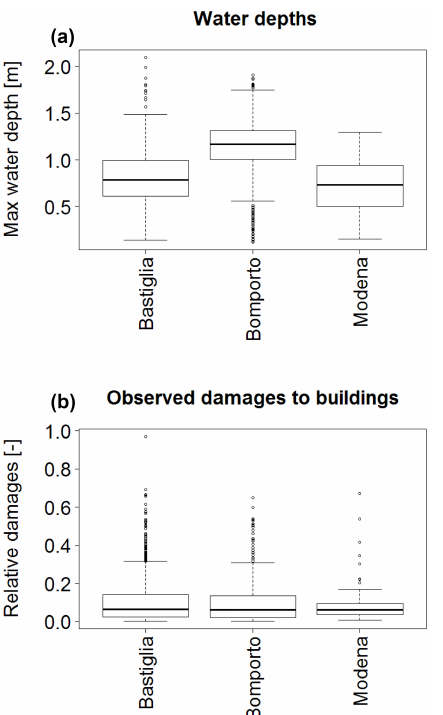
Figure 10. Distribution of water depths (a) and observed relative damages (b) in the three considered municipalities.